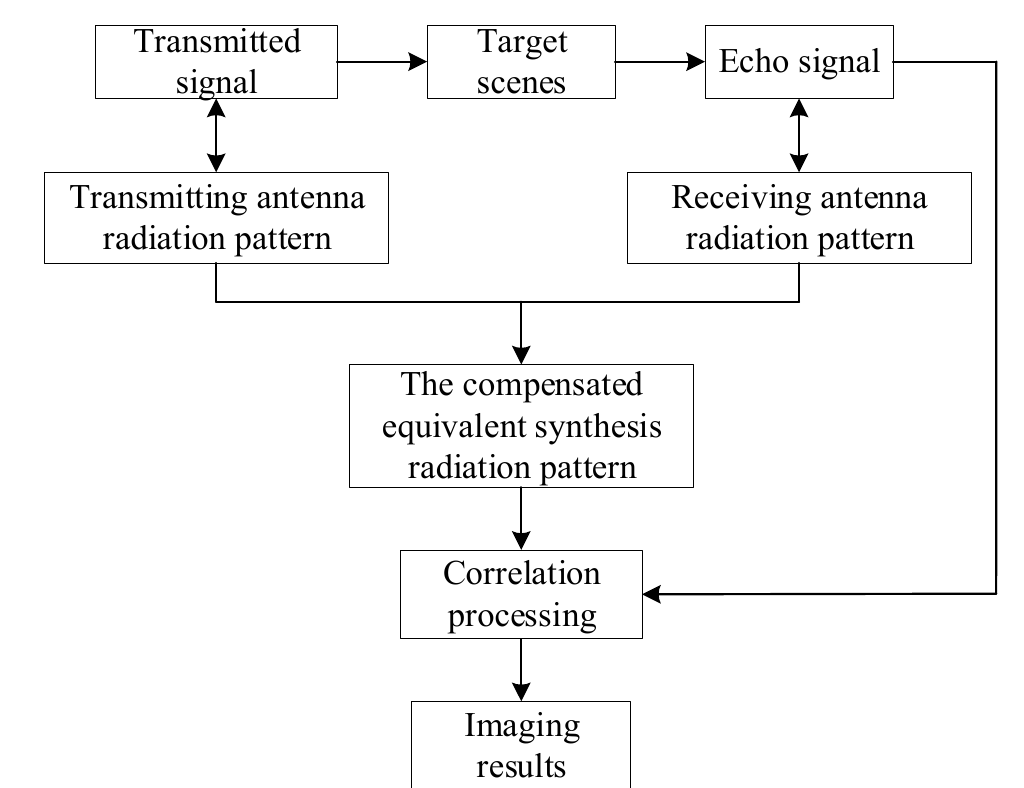
Figure 5. Flowchart of the improved correlation imaging algorithm.